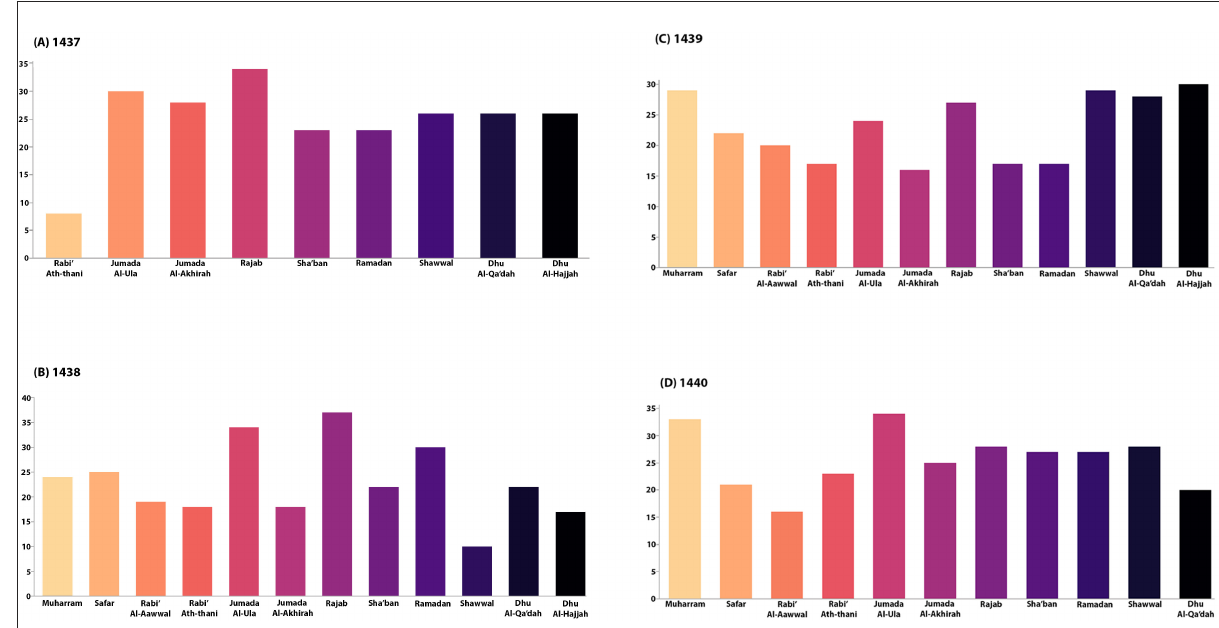
FIGURE1 The monthly distribution of Ischemic Stroke (IS) cases is stratified by different months, including Ramadan and non-Ramadan. (A) Shows the trend of IS cases per month between Rabi’ Ath-Thani 1,437 and Dhu Al-Hijjah 1,437; this corresponds to 06/June – 05/July 2016. A trend is noticed in Rajab, followed by Jumada Al-Aula. However, the trend of cases in Sha’ban and Ramadan was similar. (B) Depicts the trend of IS cases per month between Muharram 1,438 and Dhu Al-Hijjah 1,438; this corresponds to 27/May – 24/June 2017. Interestingly, most cases happened during Dhu Al-Hijjah, followed by Shawaal, Muharram. Regarding Ramadan cases, they were almost equal to Sha’ban. (C) Demonstrates the trends of IS cases per month between Muharram 1,439 and Dhu Al-Hijjah 1,439; this corresponds to 16/May – 14/June 2018. Many cases occurred during July, followed by September. (D) Illustrates the IS cases per month trends between Muharram 1,440 and Dhu Al-Qa’dah 1,440; this corresponds to 06/May – 04/June 2019. Most cases were noted in Jumada Al-Ula, followed by Muharram. Concerning Ramadan, the cases were lower than Sha’ban and